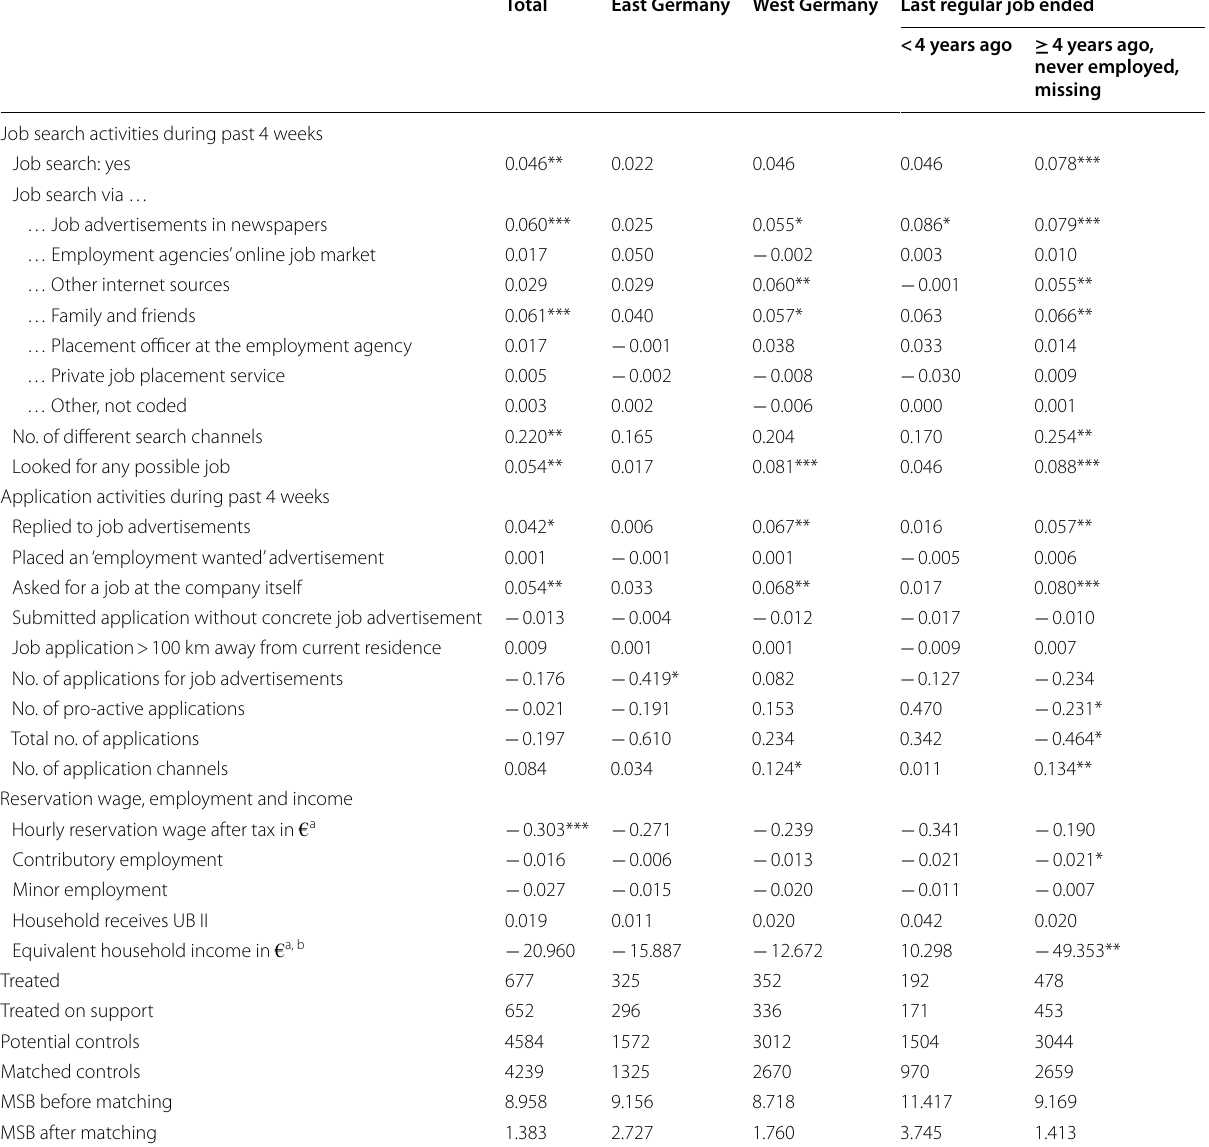
Table 10 Robustness check—ATT of receiving a One‑Euro‑Job announcement, results from PS matching